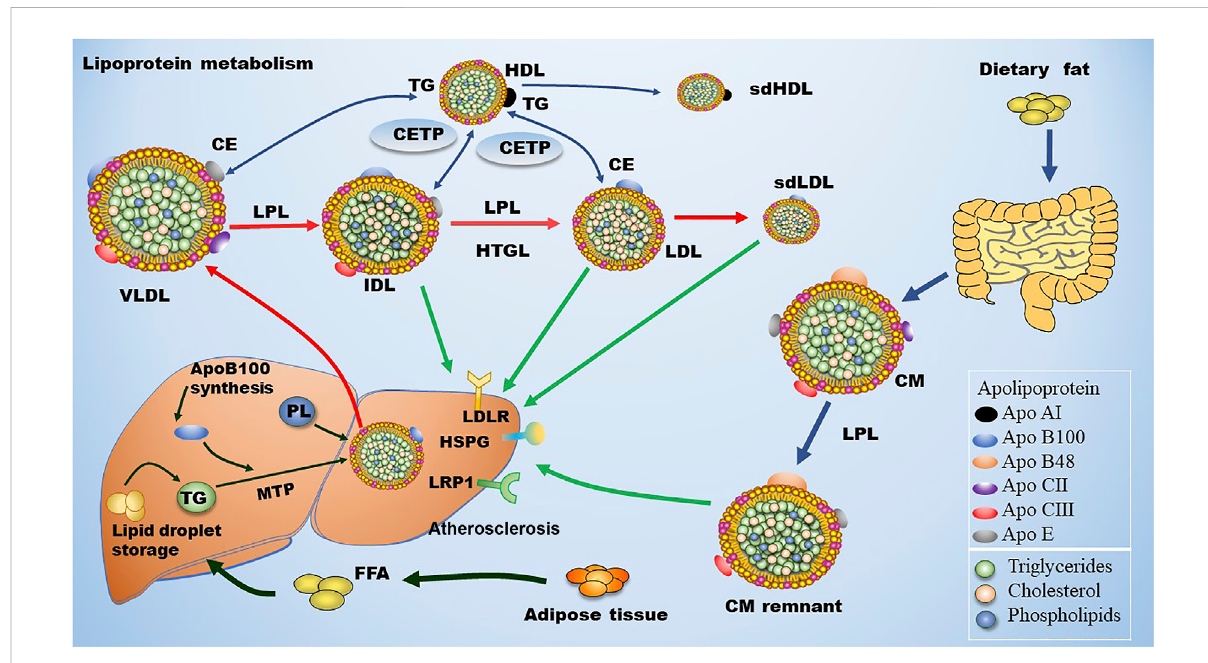
Metabolism of LDL. Dietary fat is degraded and then absorbed by intestinal cells for the assembly of chylomicron (CM), which is hydrolyzed by lipoproteinlipase(LPL)incirculationtoproducechylomicron remnant(CMR).Intheliver,apolipoproteinB(ApoB)100iscriticalforthegenerationof very low-density lipoprotein (VLDL). In blood, plasma VLDL is converted to intermediate low-density lipoprotein (IDL) and low-density lipoprotein (LDL) via hydrolysisoftriglycerides(TGs)byLPLandhepaticlipase(HL).Ofnote,cholesterylestertransferprotein(CETP)mediatestheexchange of cholesterol ester (CE) and TG between high density lipoprotein (HDL) and Apo B-containing lipoprotein, leading to the production of small dense LDL (sdLDL) and small dense HDL (sdHDL), which are atherogenic factors. CMR, IDL, LDL, and sdLDL particles can be cleared by liver through